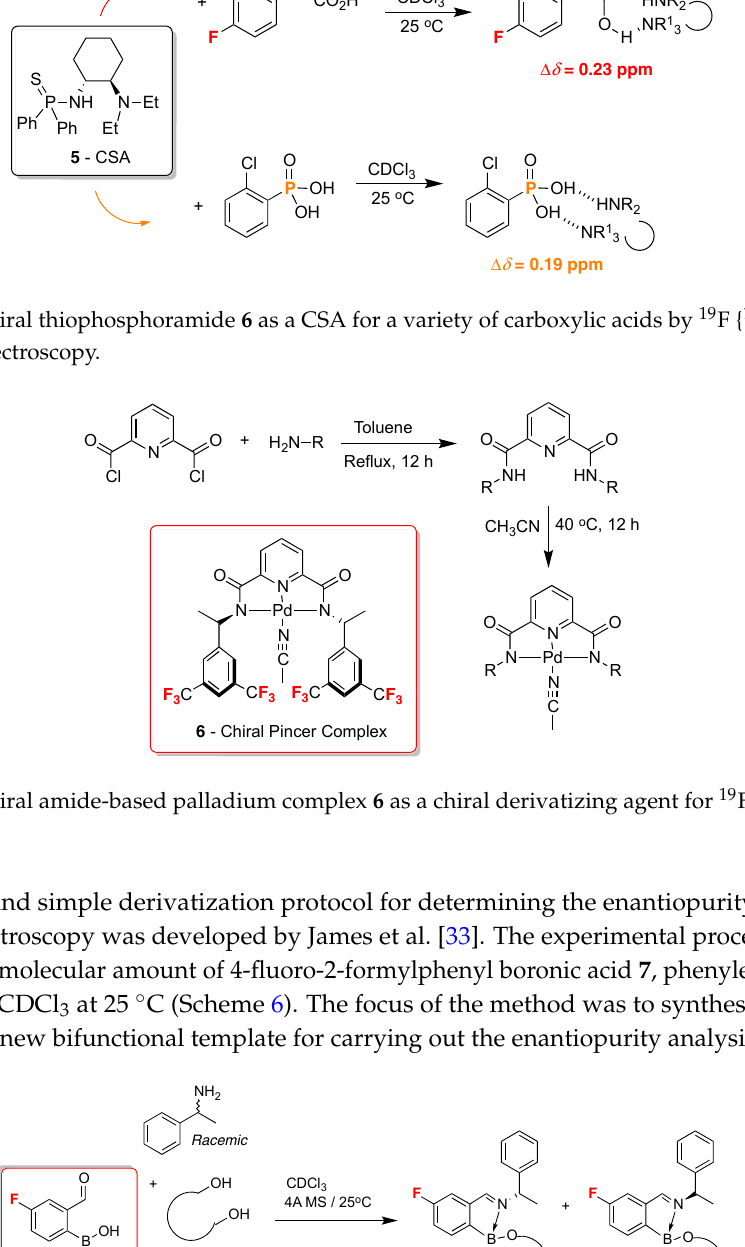
Scheme 7. Three-component coupling reaction for enatiopurity determination of diacids by 19 F { 1 H}